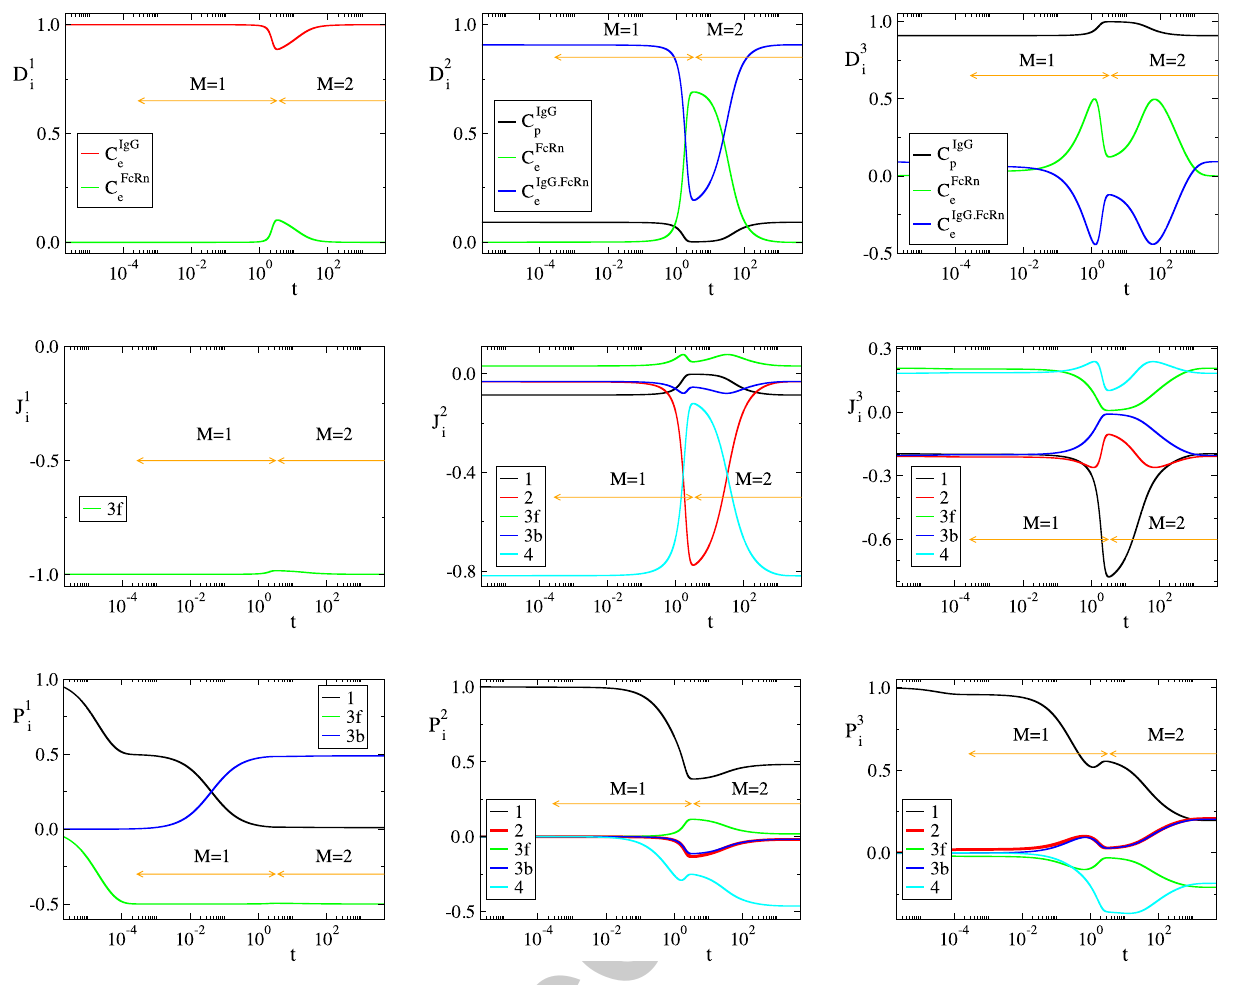
Figure 5. Evolution of CSP diagnostics for the three modes, n = 1, 2, 3 ; TOP: Pointers D n i ; i = C . FcRn C IgG e . MIDDLE: Time scale Participation Indices J Indices P n k ; k = 1, 2, 3 f , 3 b , 4